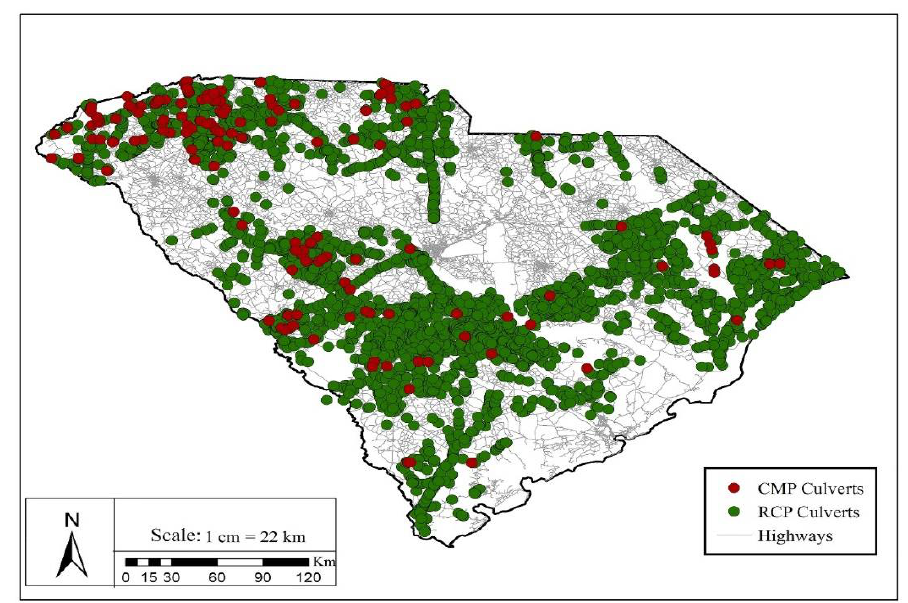
Figure 4. A map showing all the RCP and CMP culverts recorded in the SCDOT’s inventory database. Table 2. Defect mapping for RCP culverts.